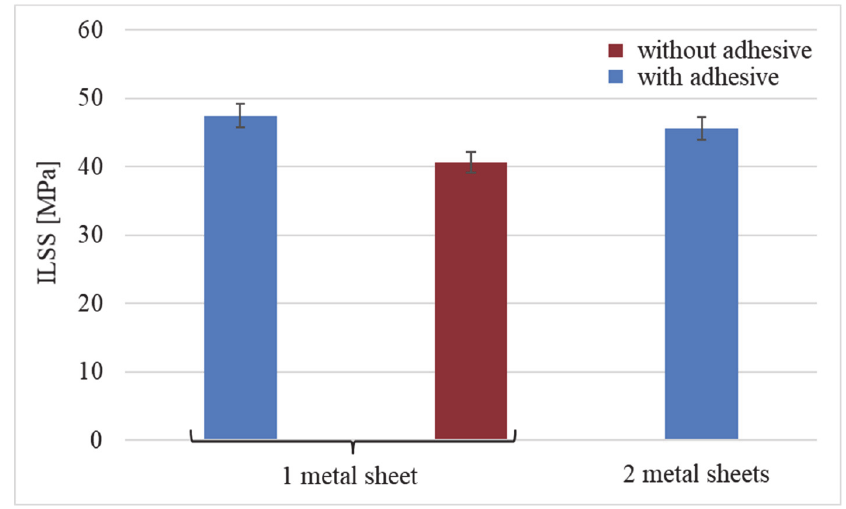
Figure 3: Results relevant to the three-point bending tests carried out on the produced FML.